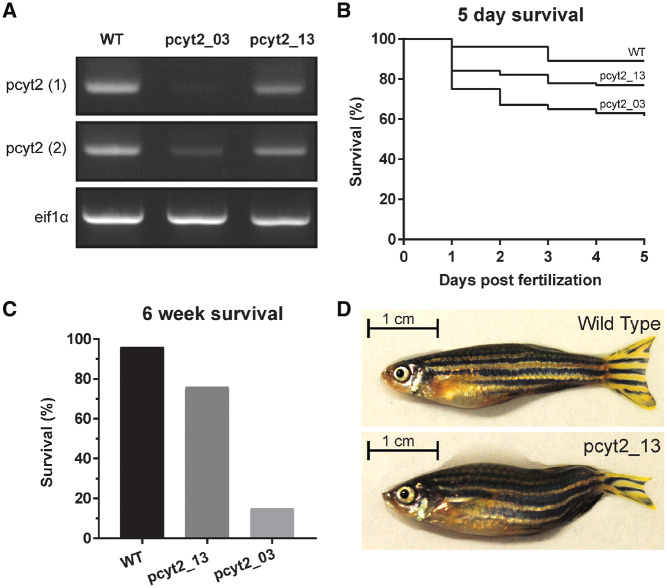

CRISPR zebrafish PCYT2 model. Two transgenic zebrafish lines were created by knocking out the third (pcyt2_03) and final 13th exon (pcyt2_13), respectively. (A) Complementary DNA expression analysis of pcyt2 using two primer sets in wild-type (WT), pcyt2_03 and pcyt2_13 showing low/absent pcyt2 expression in pcyt2_03 and moderately reduced pcyt2 expression in pcyt2_13. eif1α was used as loading control. (B) Kaplan-Meier plot for the survival of the first 5 days post-fertilization, significance was calculated using the log rank and Wilcoxon test [χ2 for equivalence of death rates: wild-type versus pcyt2_03 = 21.440258 (P < 0.0001), wild-type versus pcyt2_13 = 6.497151 (P = 0.0108) and pcyt2_03 versus pcyt2_13 = 4.700852 (P = 0.0301)]. (C) Survival at 6 weeks post-fertilization for wild-type, exon 3 and exon 13 deletion showing a significantly higher survival for the exon 13 deletion mutant, significance calculated via fisher exact test (P < 0.001). (D) The pcyt2_13 line compared with the wild-type at 6 weeks of age showing smaller overall size and abnormal tail-fin morphology.